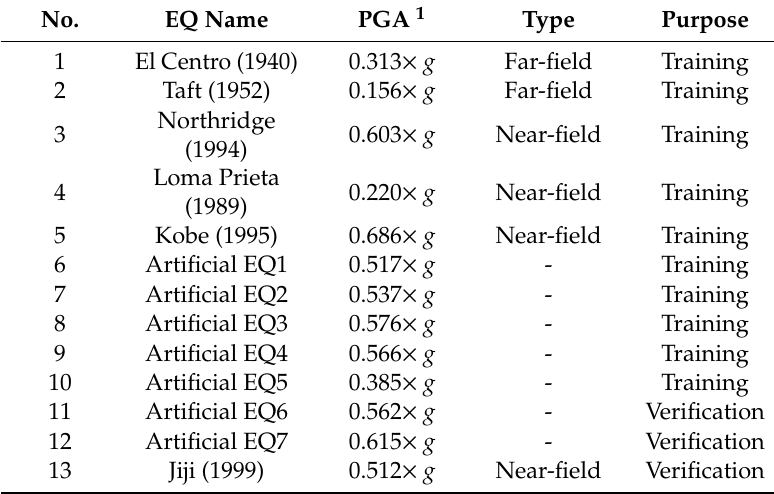
Table 2. Earthquakes for the training and verification of